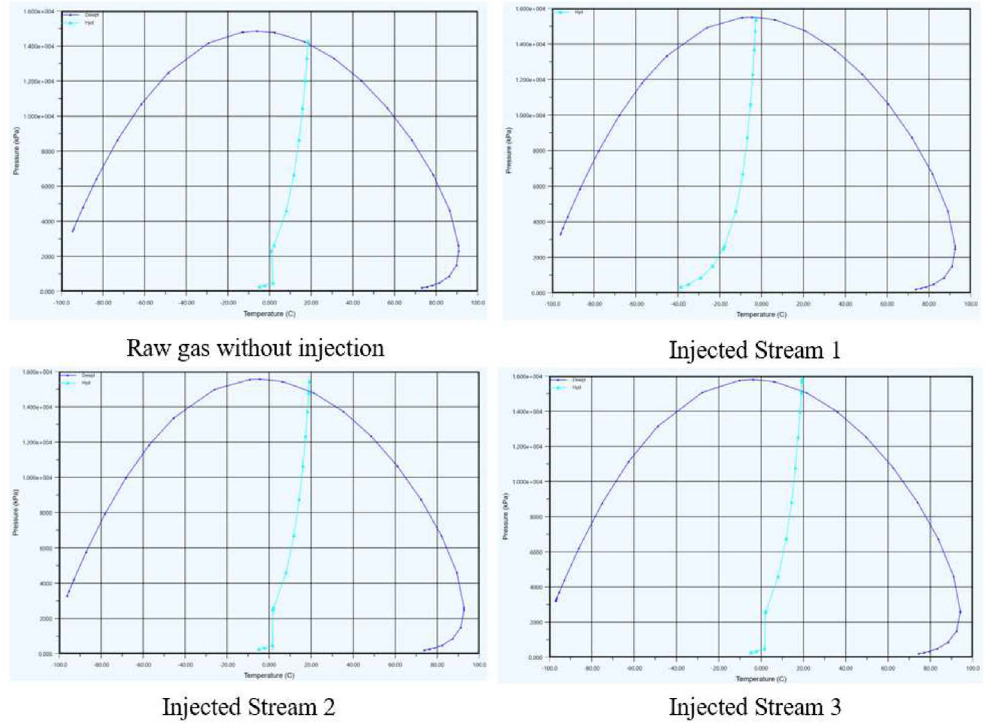
Fig. 8. The variation of gas-liquid equilibrium of raw gas with injecting